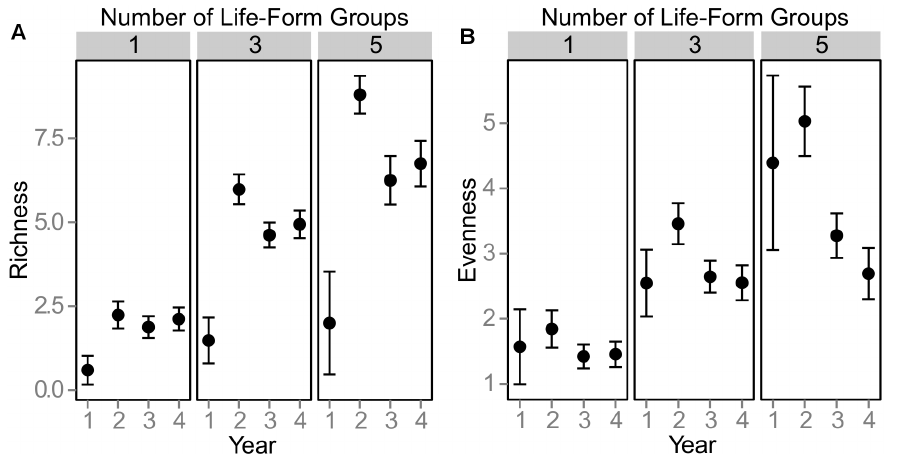
Figure 1. Canopy species richness (A) and evenness (B) over four years (means ± 95% CI). Treatments grouped by number of life-forms planted; original planted species richness was 3, 9, 15 for 1, 3, and 5 life-form groups respectively. Species evenness is 1/Simpson’s index. Sample